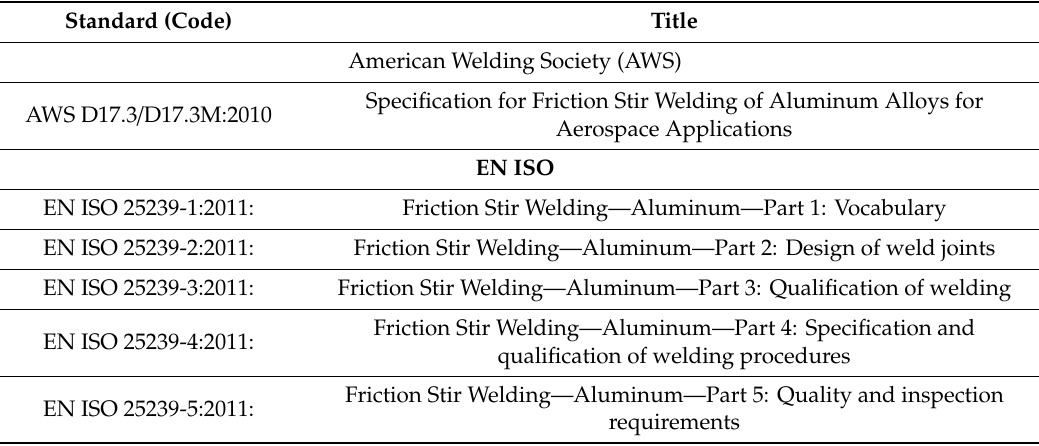
Table 1. Standards and Specification for Friction Stir Welding (FSW) of Aluminum Alloys. Standard